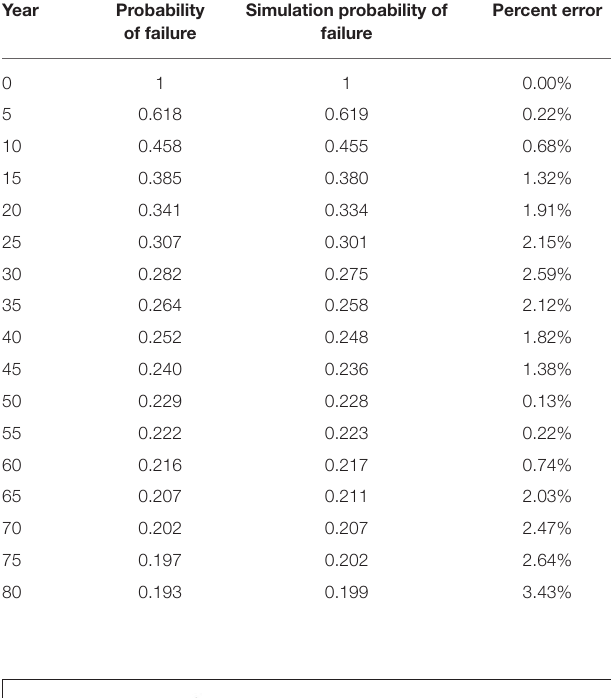
TABLE 8 | Comparison and percent error of probability of failure calculation methods for 0.04 and 0.08 m case.